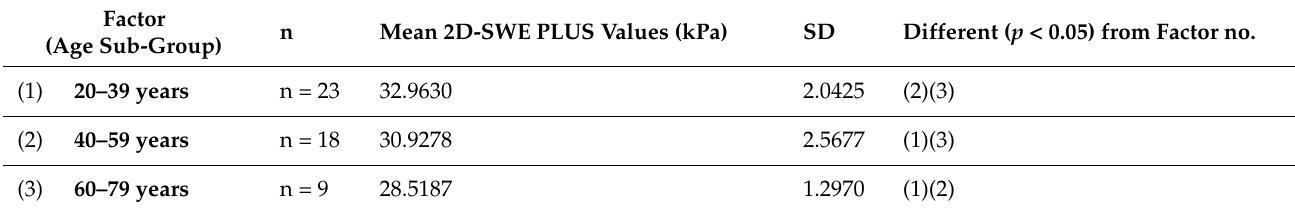
Table 2. The differences in variables among the three age sub-groups for 2D-SWE PLUS.